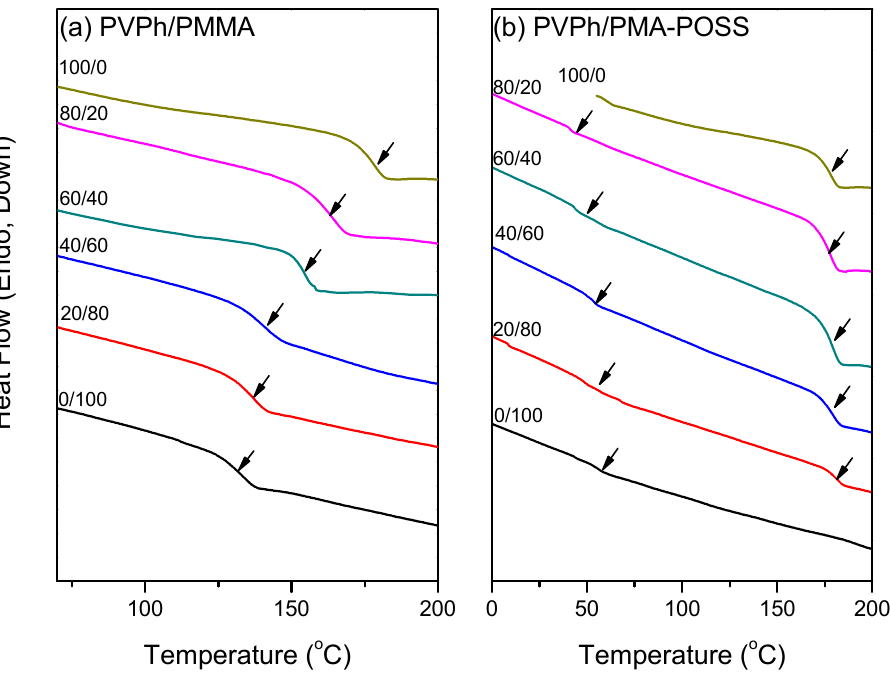
Figure 2. DSC thermograms of ( a ) PMMA and ( b ) PMA-POSS blends containing various PVPh compositions (weight